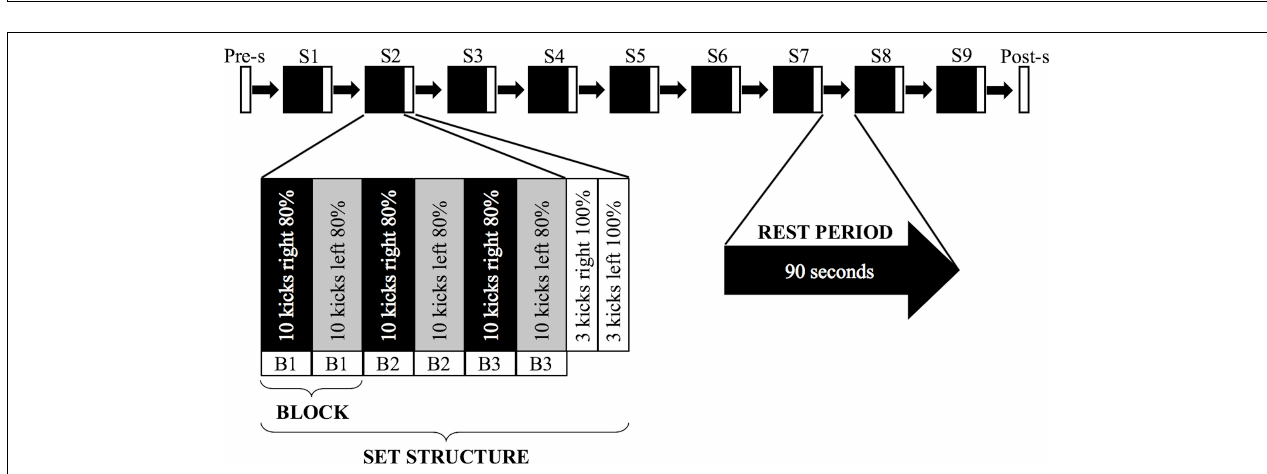
FIGURE 2 | Schematic of the test protocol. The experimental procedure consisted of one pre-set (Pre-s) followed by nine sets (S1–S9) with 90-s rest intervals in between and an additional post-set (Post-s) performed after a 10-min rest period. A deeper insight into the structure of the main elements is represented below. The pre-set and post-set consisted of six mae-geri kicks performed at maximal intensity ( K -100). Adapted from Aragonés et al. (2018).